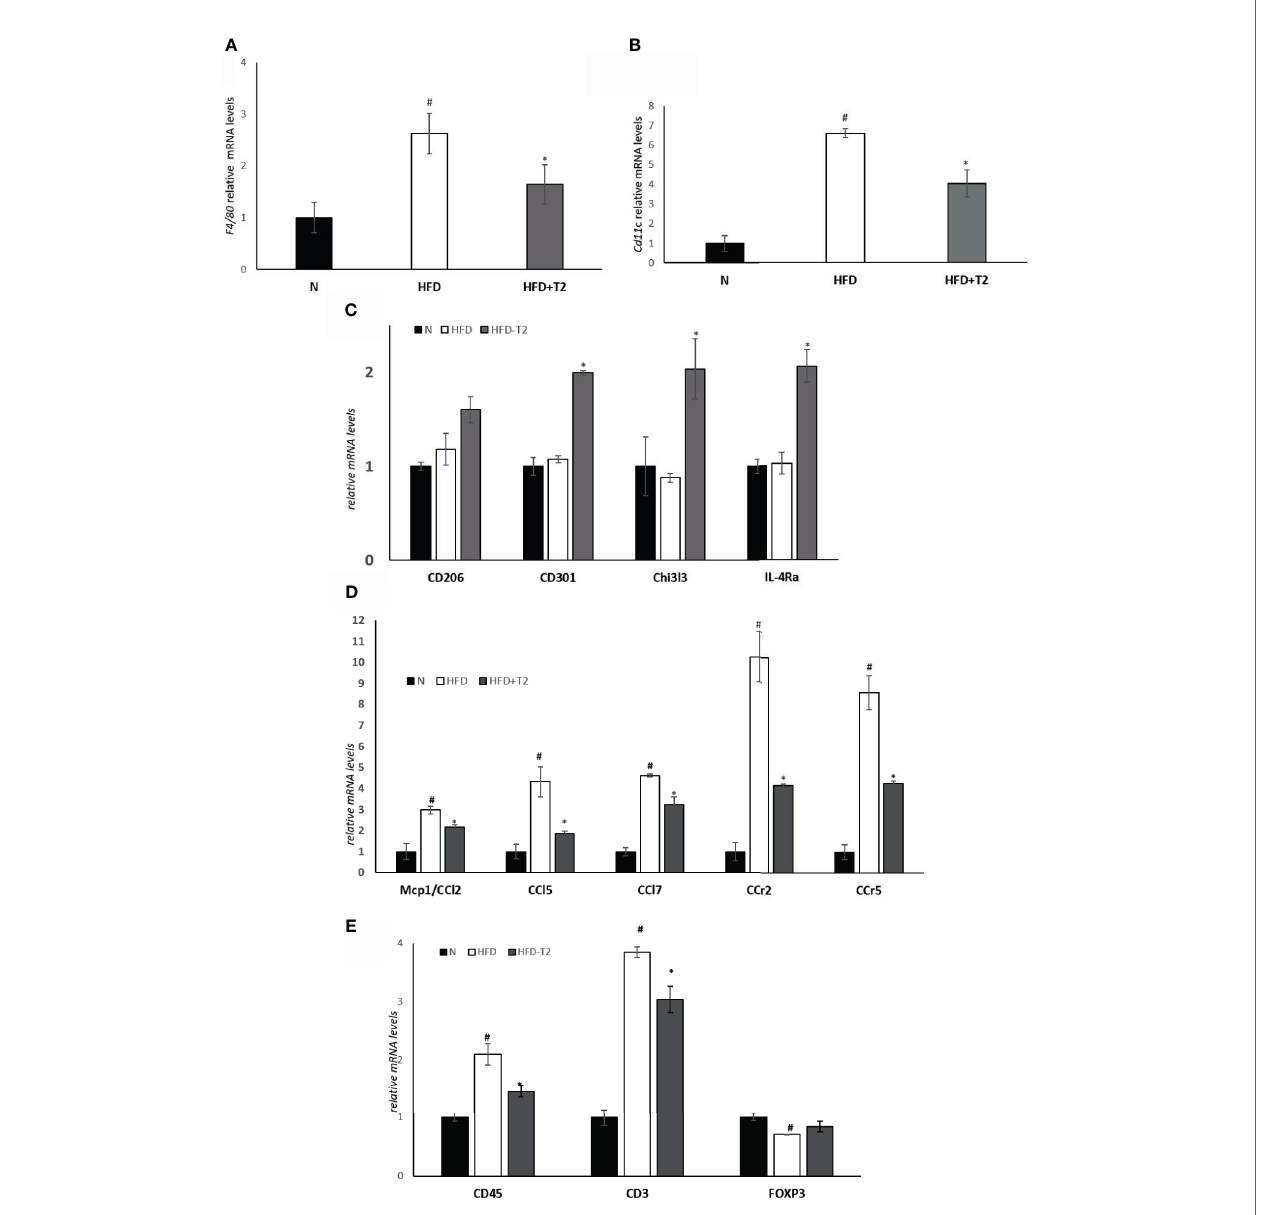
FIGURE 3 | Effect of T2 administration on expression of markers of macrophage in fi ltration and adipose tissue lymphocytes in vWAT. RT-qPCR analysis of (A) F4/ 80, (B) CD11C and (C) CD206, CD301, Chi3l3, IL-4Ra, (D) Mcp1/CCl2, CCl5, CCl7, CCr2, CCr, (E) CD45, CD3, FOXP3 in vWAT of N, HFD, and HFD-T2 rats. The histograms represent means ± SEM of fi ve independent experiments (n = 5), # P < 0.05 vs. N; *P < 0.05 vs. HFD. N: rats receiving a standard diet for 14 weeks; HFD: rats receiving a HFD for 14 weeks; HFD-T2: rats receiving a HFD for 14 weeks with a daily administration of T2 during the last 4